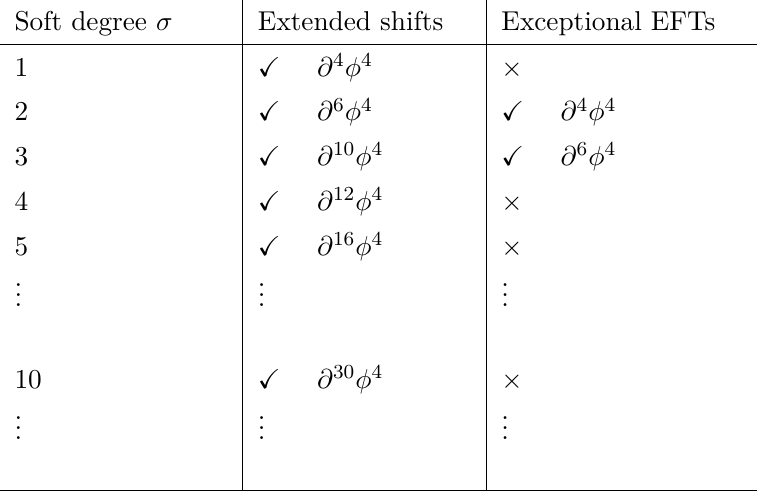
Table 1. The full classification of scalar EFTs with generalised Adler zero soft behaviour with the power counting of leading order four-point vertices. For even σ these vertices have 3 σ derivatives and for odd σ they have 3 σ + 1